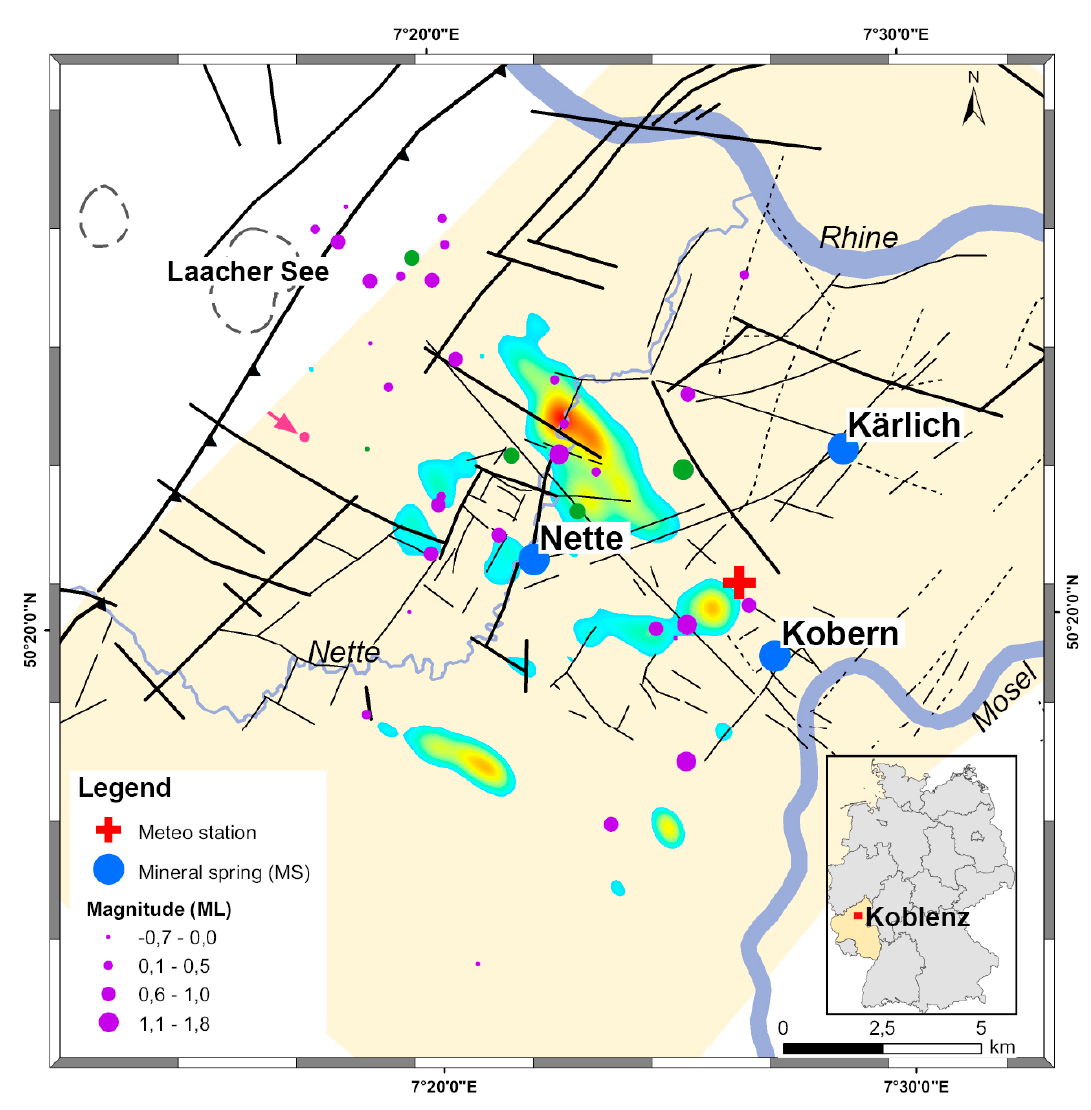
Figure 9. (M L ) of earthquakes during the 7-M field campaign (purple dots). The five earthquakes, which occurred between 1 and 12 km distance from the springs during the 4-W sampling, are marked by green dots. The DFL-earthquake near Niedermendig (pers. comm. Erdbebendienst Südwest) is marked in magenta (arrow). For further explanation of the legend see Figure 1a.